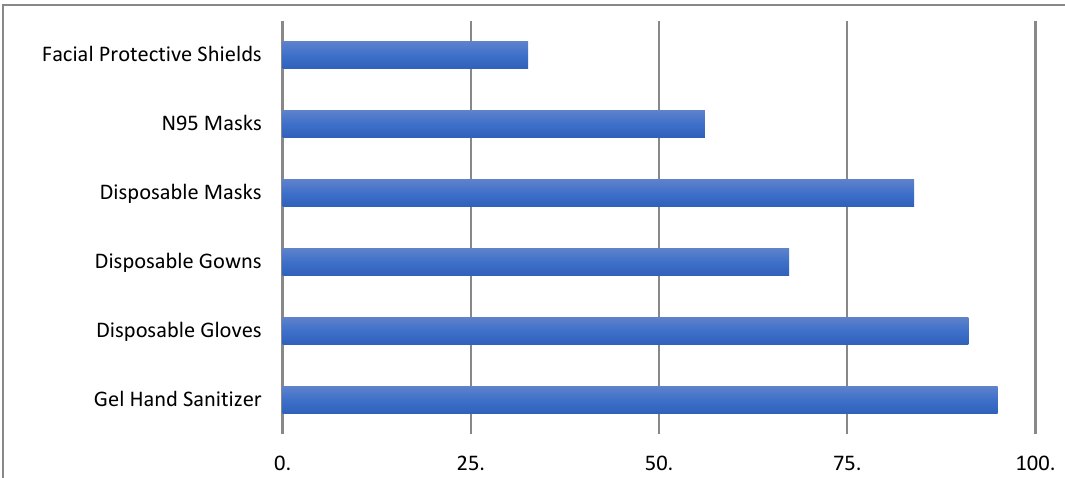
Figure 2. Access to personal protective equipment (PPE). Types of PPEs (%) accessible to healthcare workers.